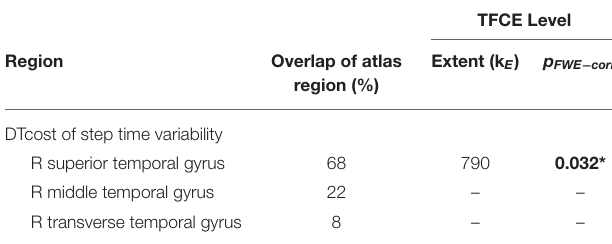
TABLE 5 | Regions of age difference in the relationship of structural ROIs with the DTcost of gait speed.